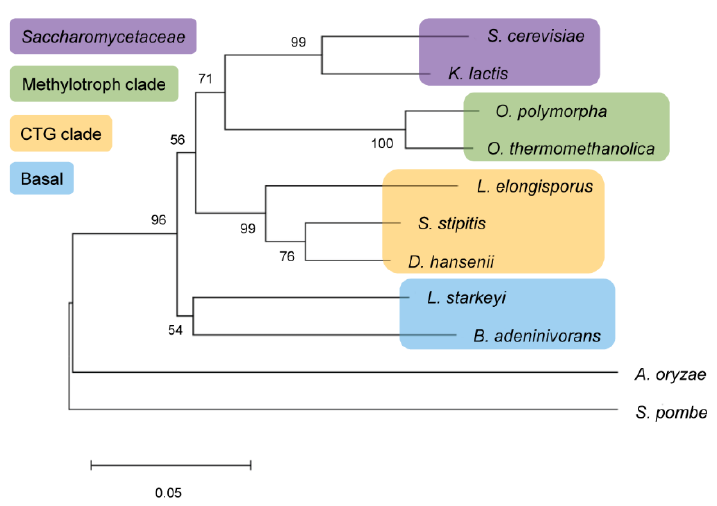
Figure 9. Phylogram based on analysis of D1 / D2 domains of large subunit ribosomal RNA (rRNA) gene sequences of ten yeast species and of a filamentous fungus Aspergillus oryzae . The bootstrap values (1000 replicates) are shown at the nodes. The scale bar shows the number of base substitutions per site. The Saccharomycotina clades according to [50] are designated by background coloring.